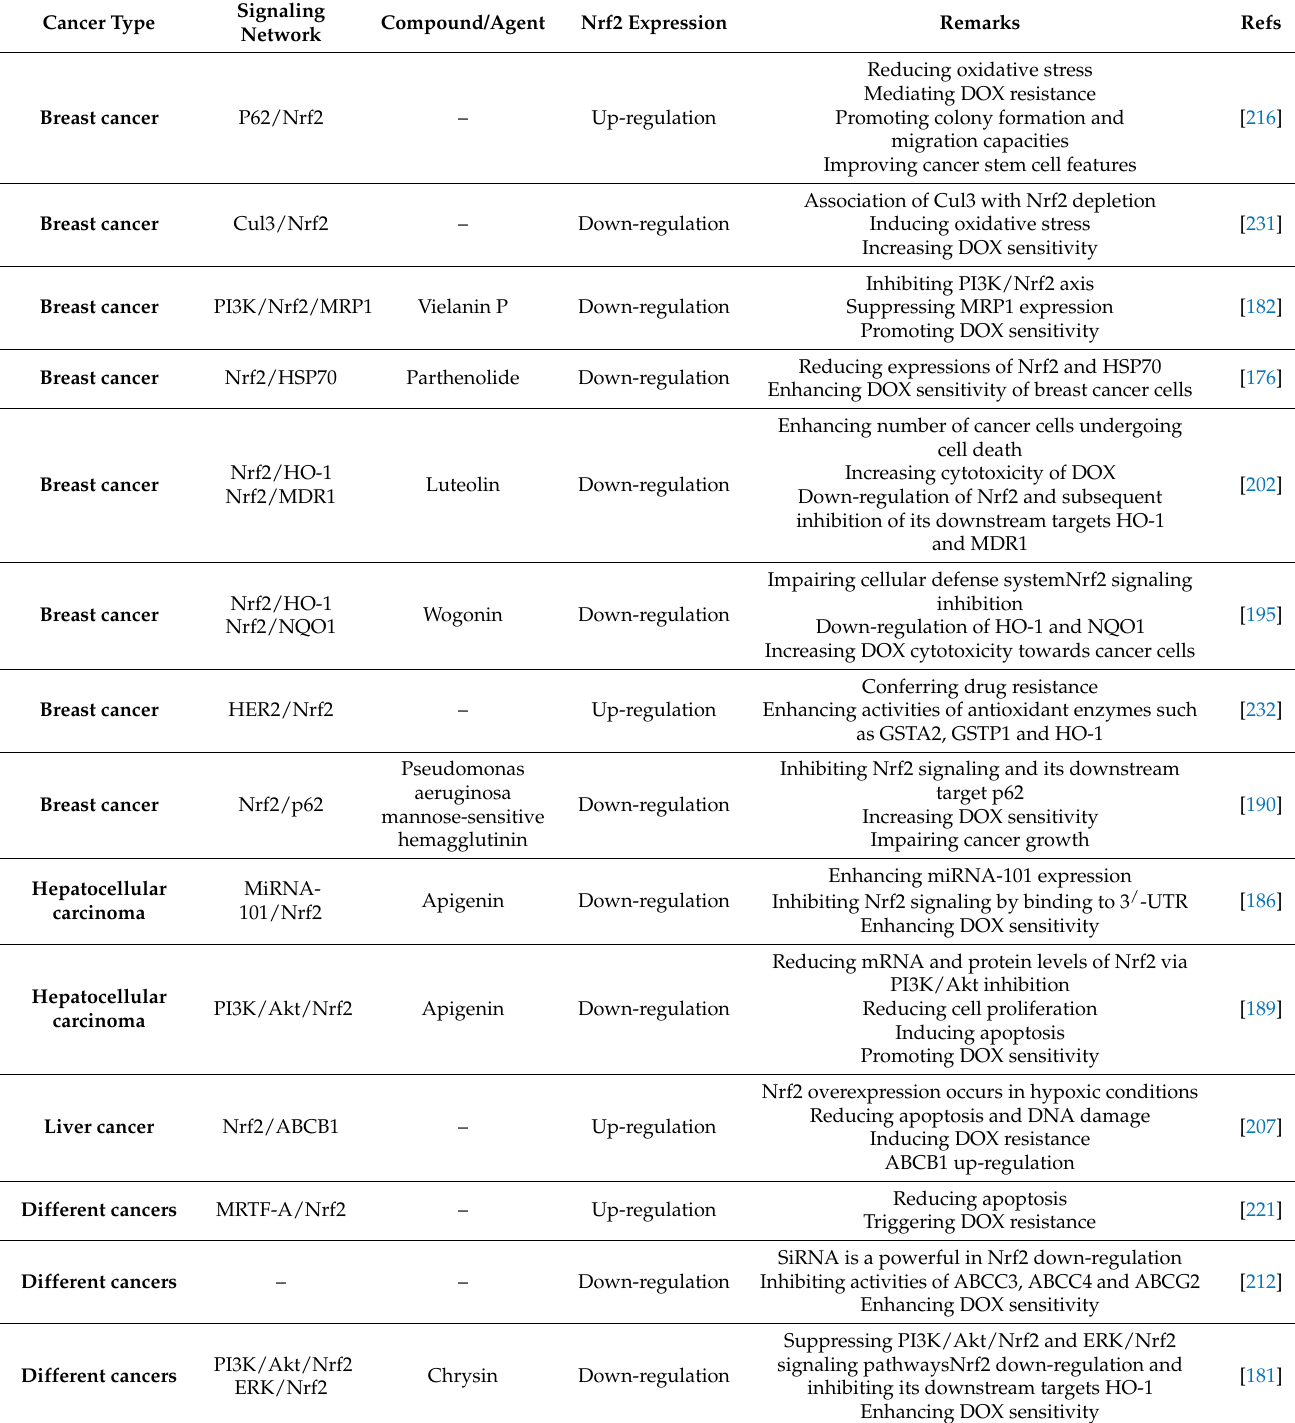
Table 2. Activation/suppression of Nrf2 signaling and its association with DOX resistance/sensitivity. Cancer